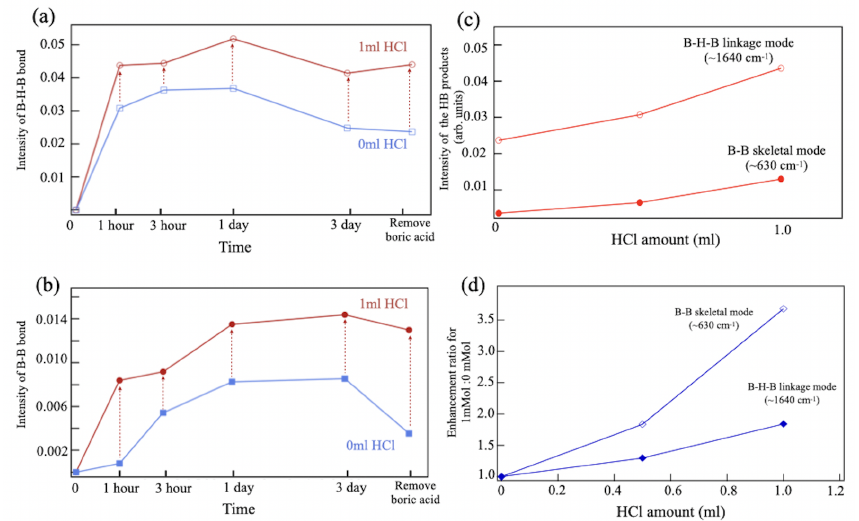
Figure 8. ( a , b ) Variations of the FT-IRAS intensity at around ( a ) 630 cm − 1 (B-B skeletal mode) and ( b ) 1640 cm − 1 (B-H-B linkage mode) at steps in the synthesis for different reaction times and post-treatments. ( c , d ) Changes in ( c ) intensity and ( d ) the ratio of the FT-IRAS signals around 630 and 1640 cm − 1 with hydrochloric acid